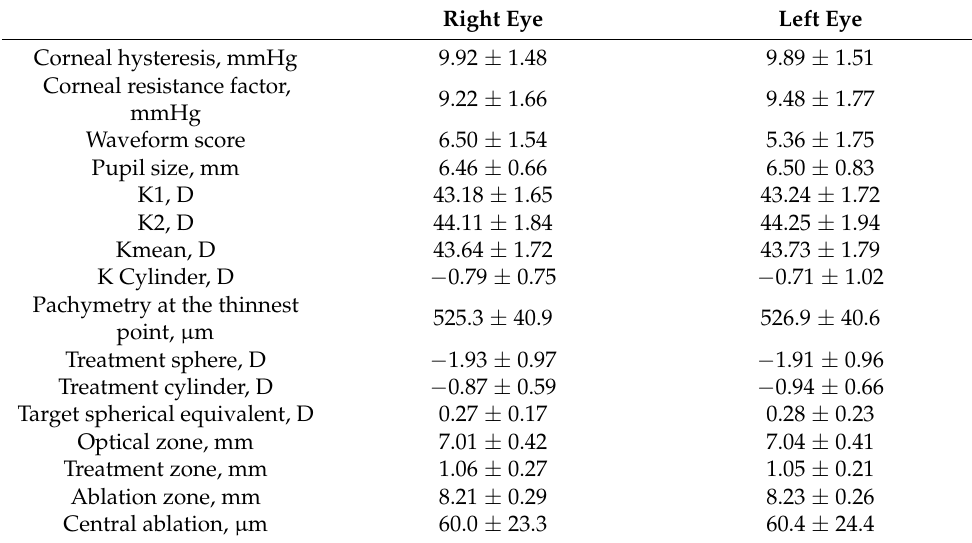
Table 3. Baseline demographics, pre- and intraoperative parameters.